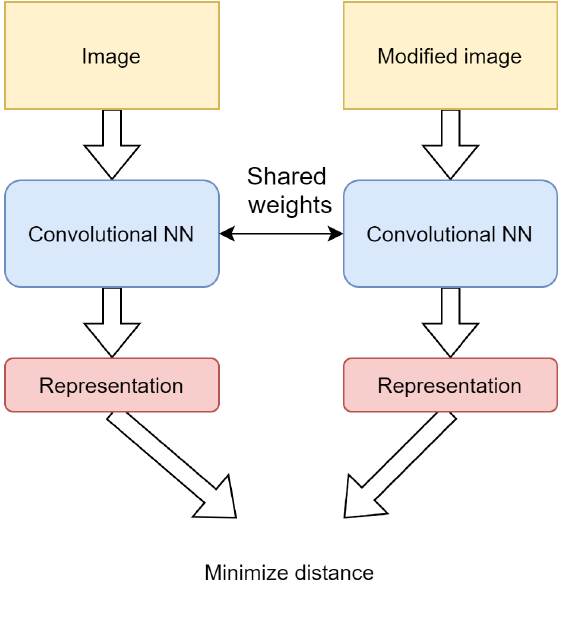
Figure 2. The idea of contrastive learning. Contrastive learning leads to representations that are invariant to transformations and retain semantic